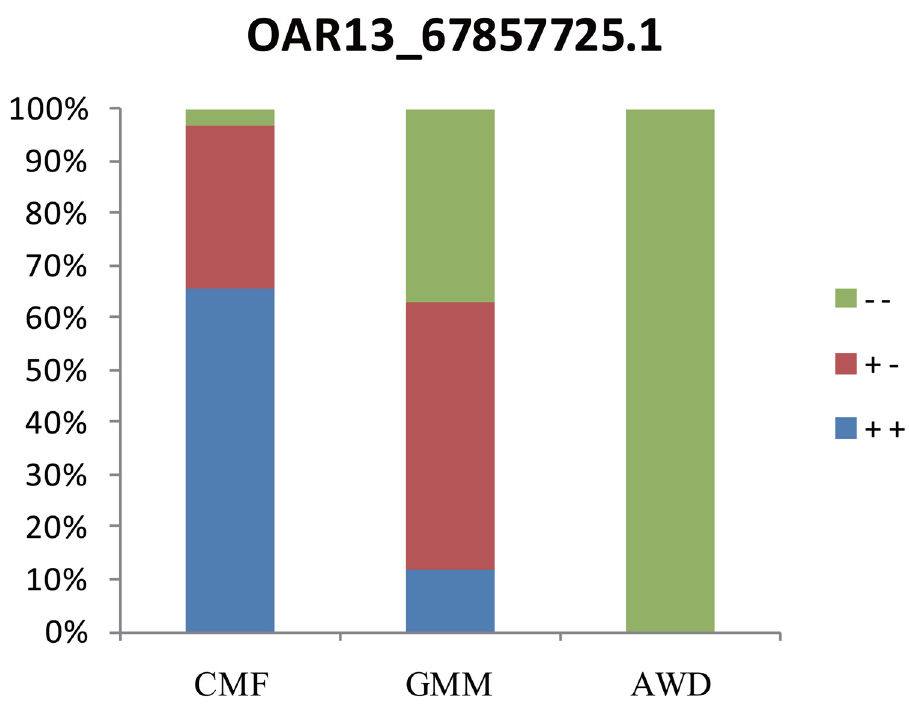
Fig 7. The diversity of OAR13_67857725.1 SNP in 3 sheep breeds.